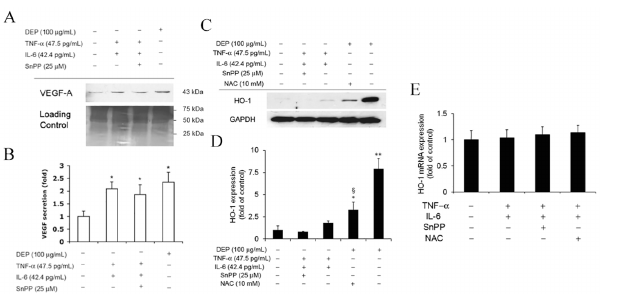
Fig 4. Addition of TNF- α and IL-6 triggered release of VEGF-A from endothelial tube cells. (A) The tube cells were treated with 47.5 and 42.4 pg/mL TNF- α and VEGF-A, respectively, and incubated for a 24 h. The medium was collected and subjected to SDS-PAGE. Half the gel was used for western blot analysis, probing with anti-VEGF-A antibodies, and the other half was identically loaded as a loading control, stained with Coomassie blue. (B) Semiquantitative analysis of the intensity of VEGF-A bands from the blot. Furthermore, TNF- α plus IL-6 independently stimulated HO-1 expression. (C) Analysis of HO-1 expression in HUVEC tube lysates was performed using immunoblotting. Equal protein loading was confirmed with GAPDH immunoreactivity. (D) Semiquantitative analysis of the intensities of HO-1 bands from the blot. § indicates p < 0.05 significance decrease from DEP (100 g/mL) to NAC+DEP (100 g/mL). (E) HO-1 mRNA expression response to TNF- α and IL-6 was quantified using qPCR, with normalization to 18S. HO-1 expressed in the negative control was defined as 1. Values are expressed as the fold-change compared to the negative control (n = 3). Significance was reached at * p < 0.05 as analyzed using Student ’ s